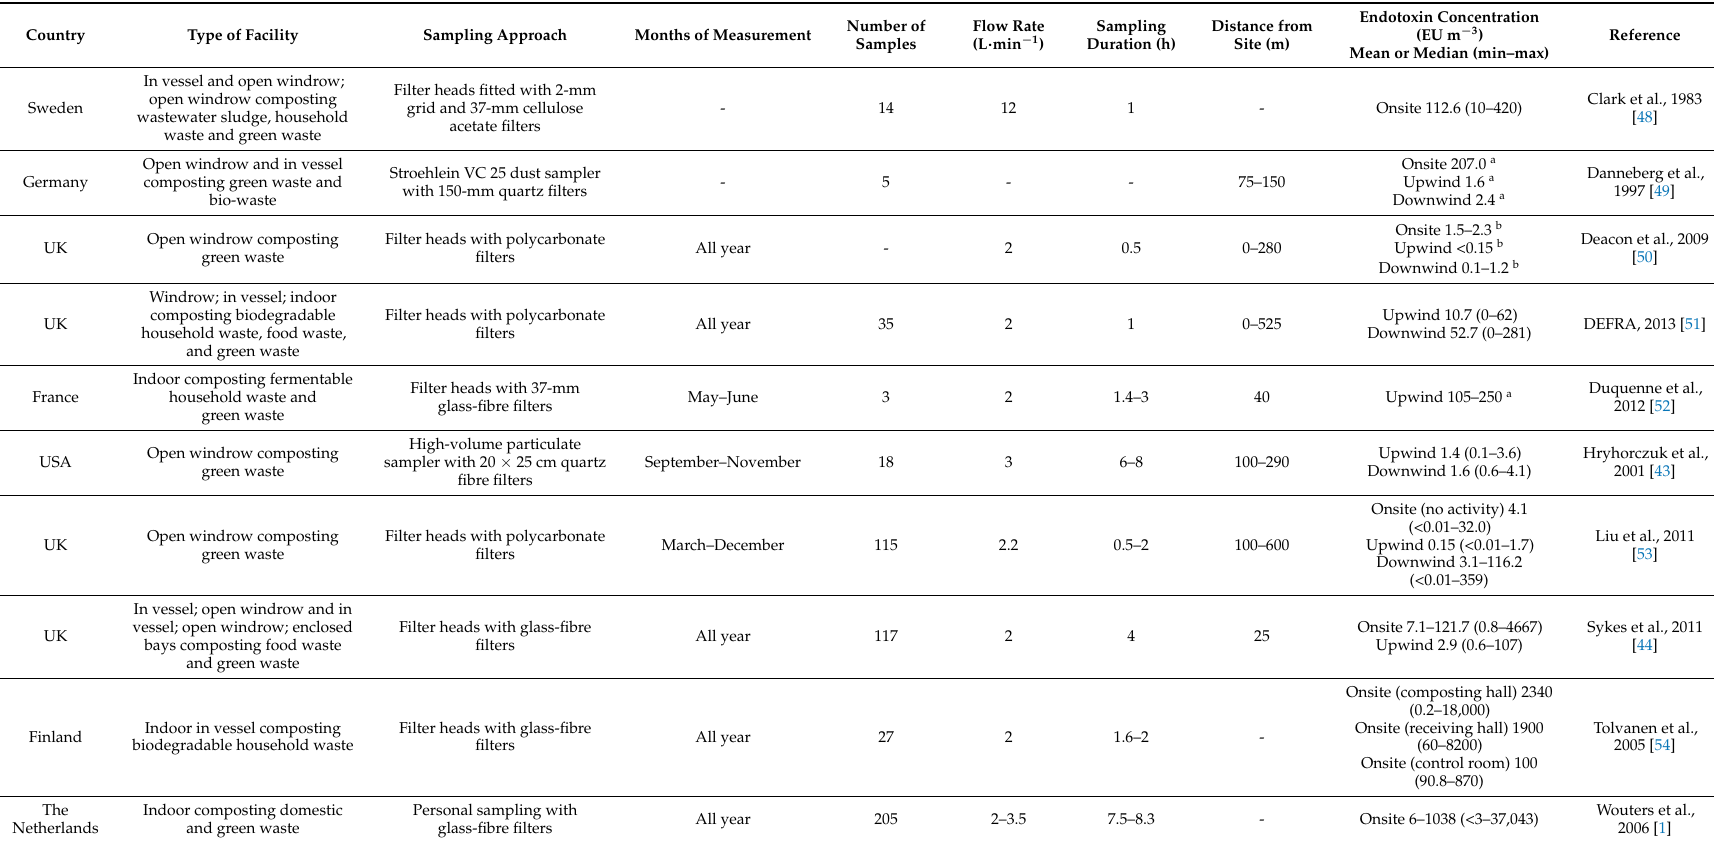
Table 2. Endotoxin emissions from composting facilities as reported in the literature. UK—United